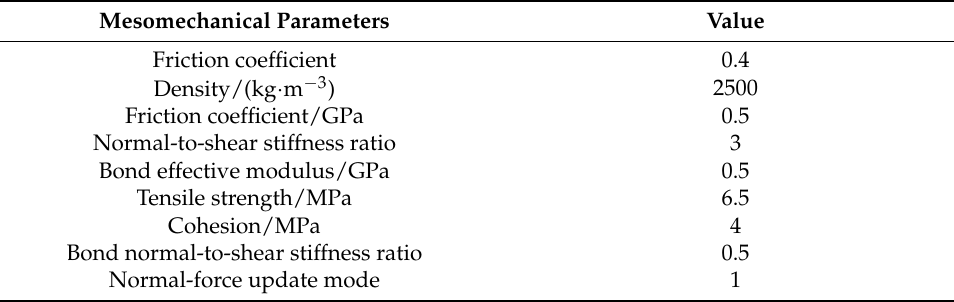
Table 4. Numerical simulation test